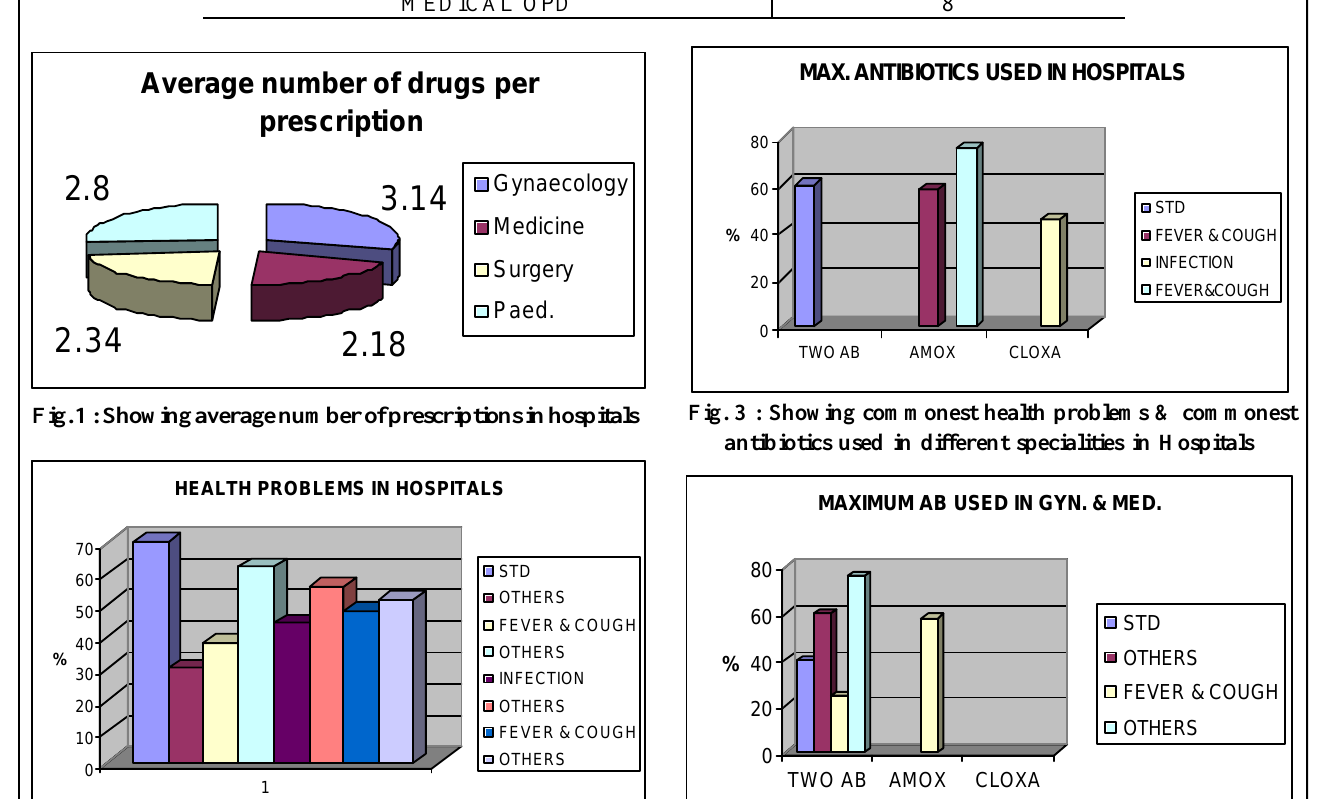
Average number of drugs per